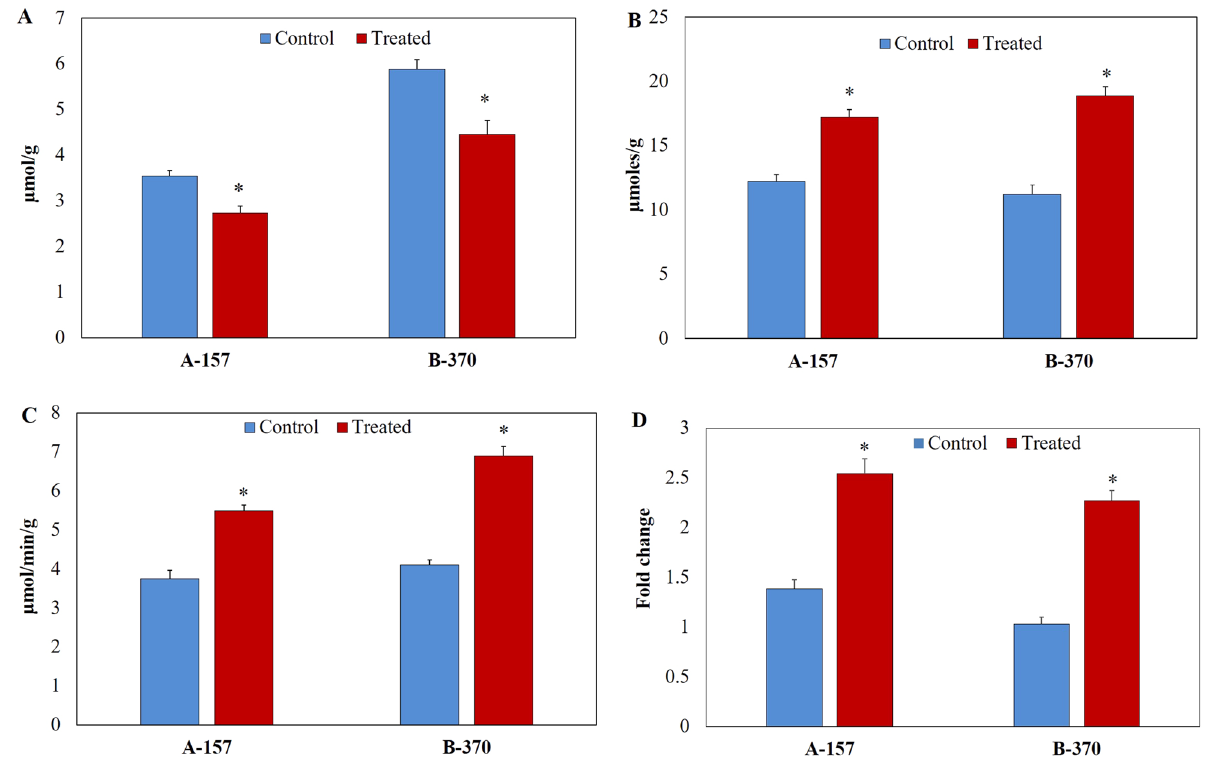
Figure 2. Determination of ( A ) Glutamate, ( B ) Proline content, ( C ) P5CS enzyme assay and ( D ) P5CS gene expression in the leaf tissue of aromatic rice cultivars grown under salt stress.